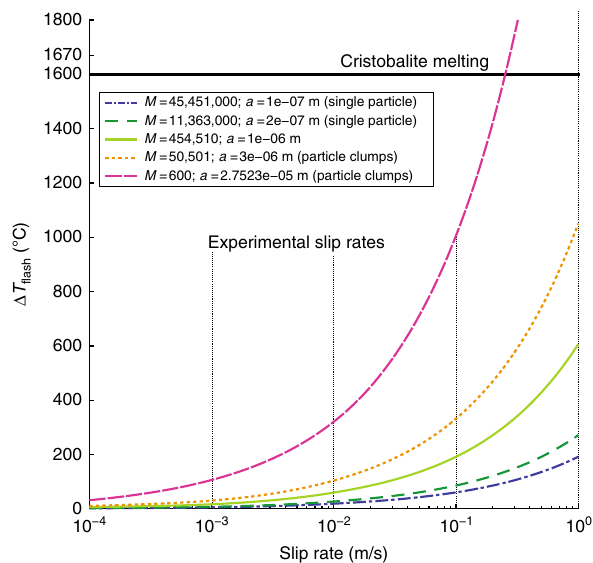
Fig. 2 Flash heating temperature at asperities. Temperatures calculated for slip rates from 10 − 4 – 10 0 m/s at normal stress = 2.5 MPa, showing the effect of asperity size ( a ) and number ( M ), between the size of